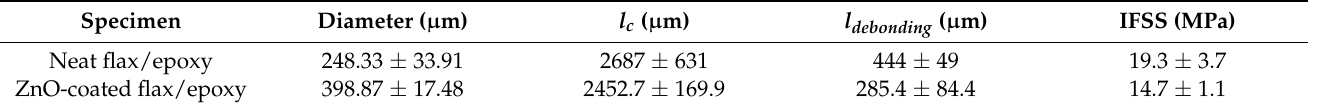
Table 1. Diameter, critical length ( l c ), debonding length ( l debonding ) and interfacial shear strength values (IFSS) for ZnO-coated flax/epoxy single yarn composite and for neat flax/epoxy single yarn